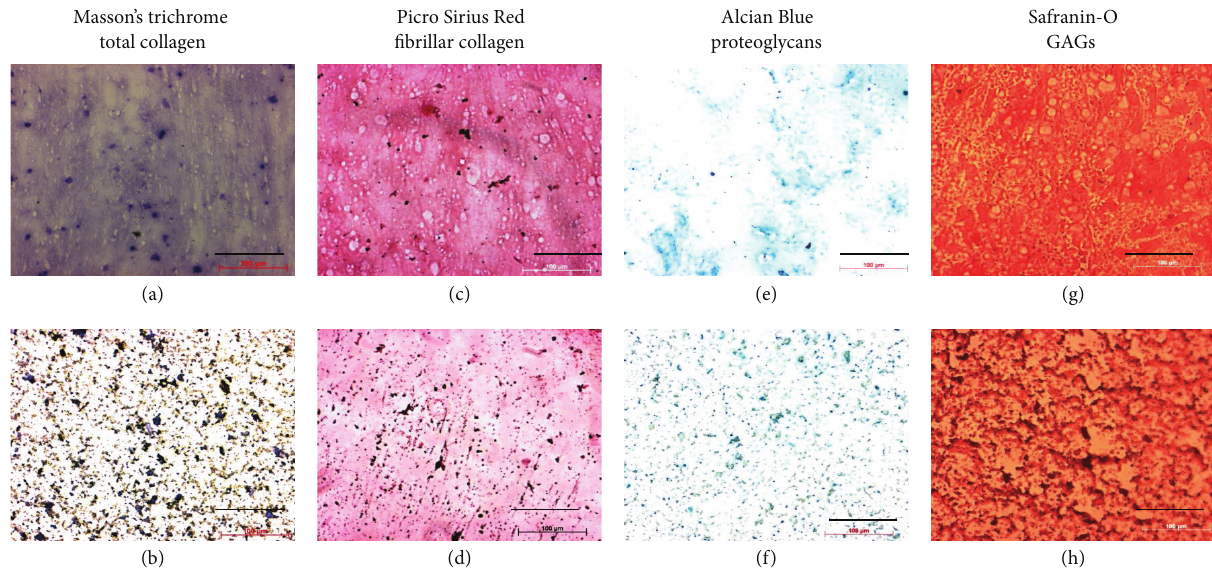
Figure 6: Cytochemical characterization of ACM (“(a), (c), (e), and (g)” indicate native ACM and “(b), (d), (f), and (h)” indicate spin coated ACM). (a) and (b) Masson’s trichrome staining of collagen, (c) and (d) Picro Sirius Red staining of fibrillar collagen, (e) and (f) Alcian Blue staining of proteoglycans, (g) and (h) Safranin-O staining of GAGs (scale bar: 100 𝜇 m).